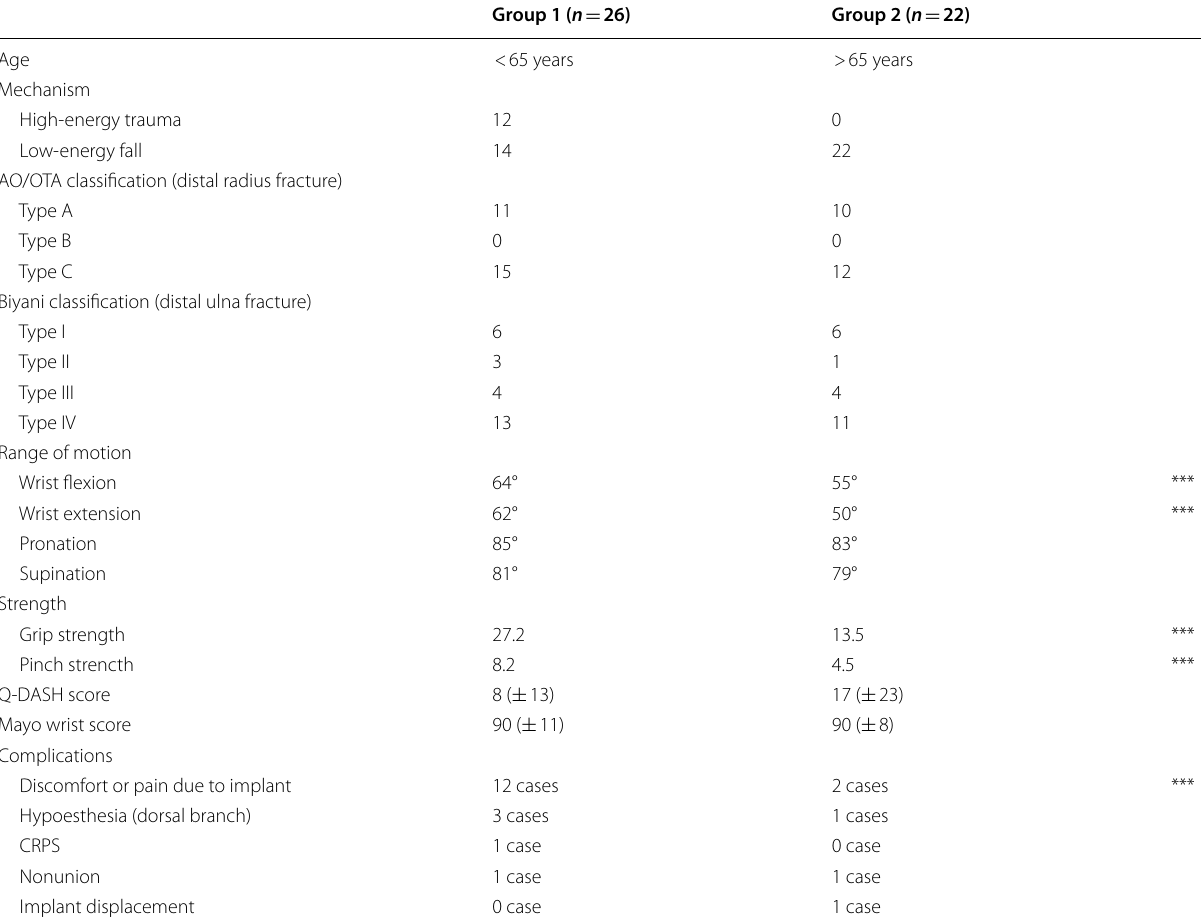
Table 3 Comparison between younger and older patients treated with distal ulna hook plate osteosynthesis